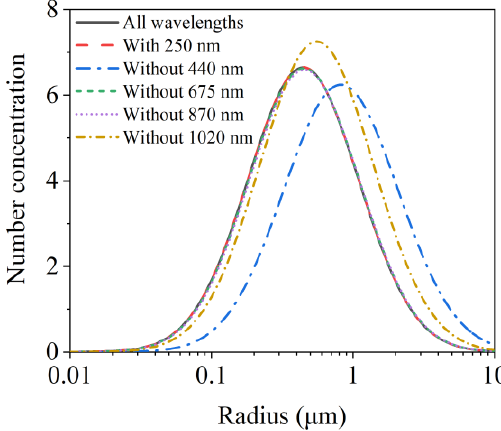
Figure 8. The PSD characteristics under different inversion samples.